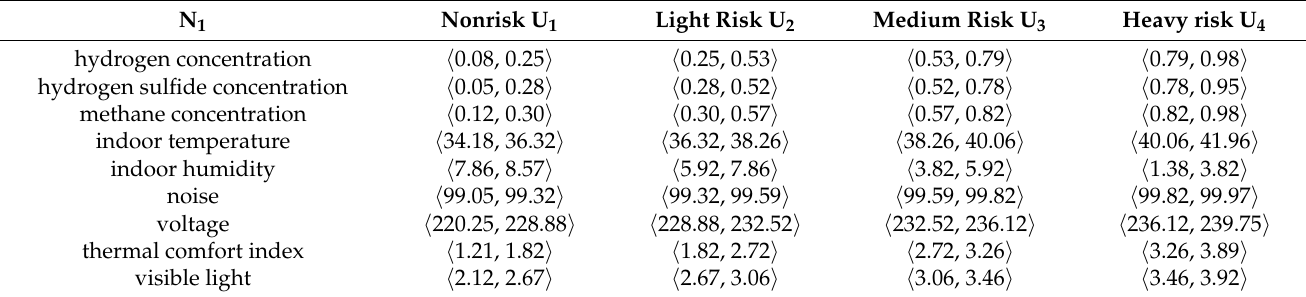
Table 4. Classical field of indoor safety and environment indexes (N 1 ).